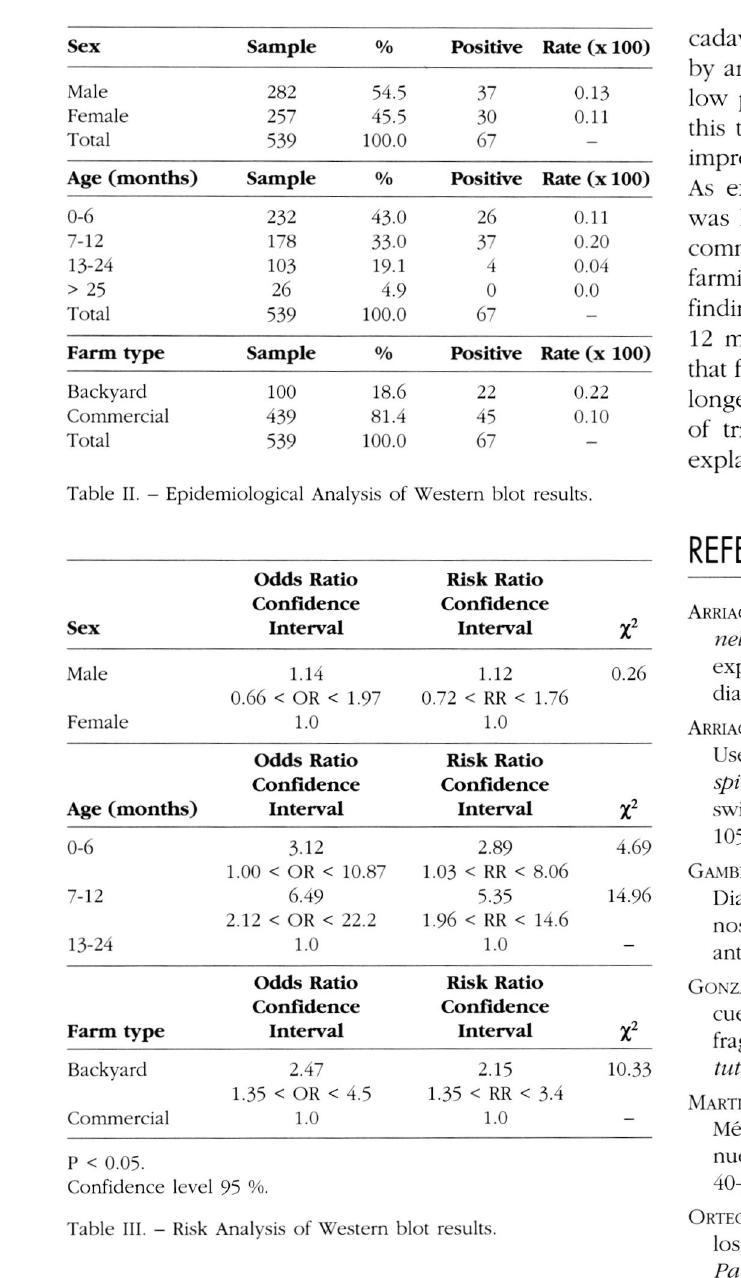
Table III. - Risk Analysis of Western blot results.